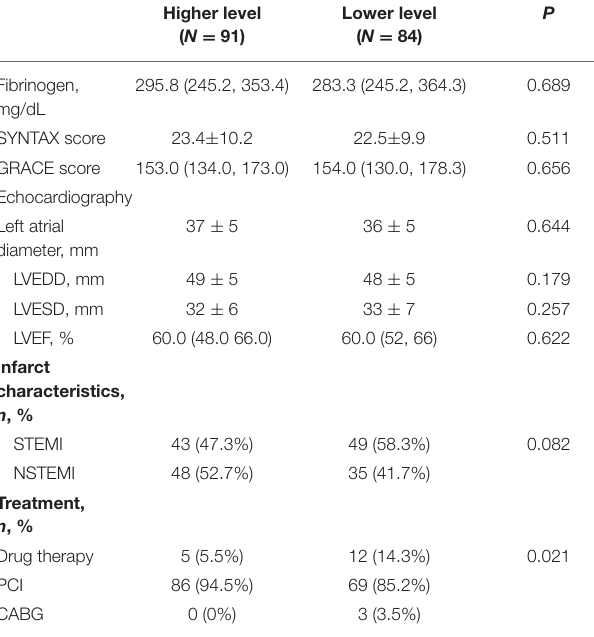
TABLE 2 | Association between Plasma TSLP and clinical parameters in UA and AMI